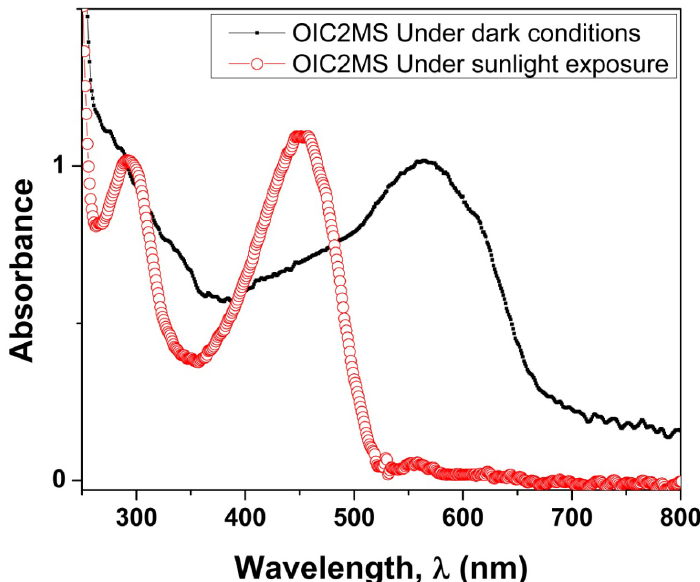
Figure 6. Absorption spectrum of OIC2MS under dark conditions without photo irradiation (red-open line) and photochromic effect of OIC2MS in chloroform upon sunlight irradiation (black-solid line) at room